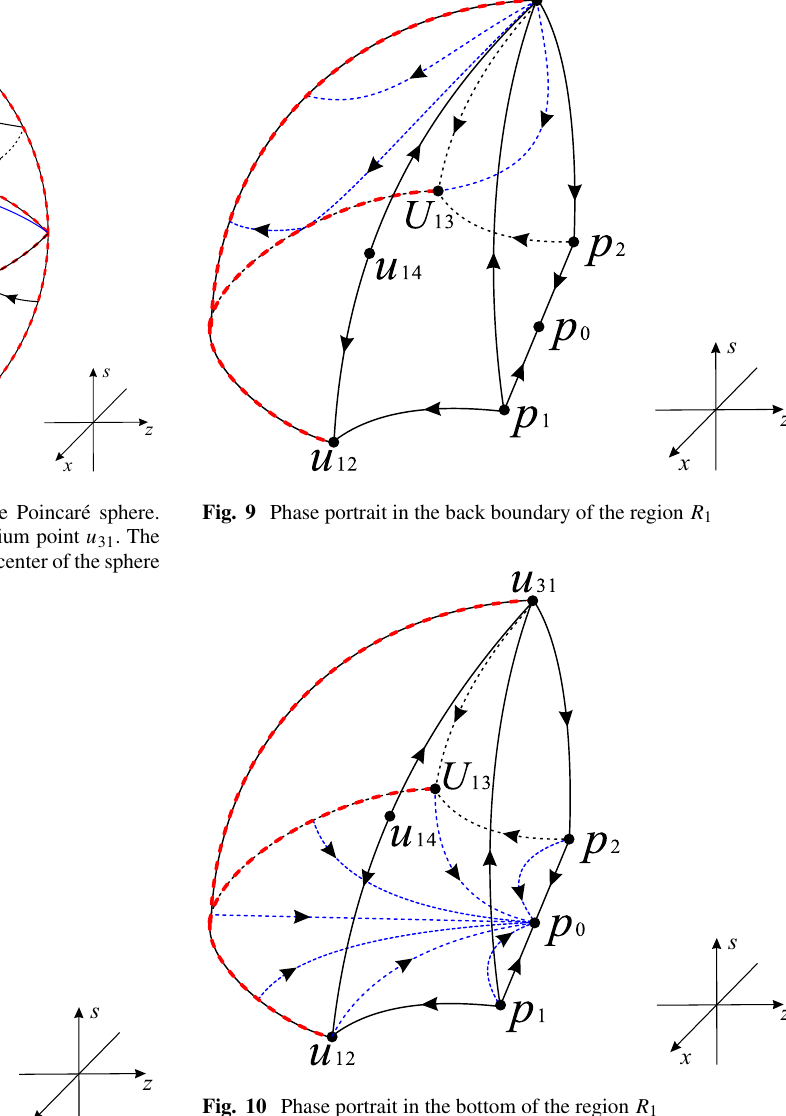
Fig. 10 Phase portrait in the bottom of the region R 1 parabolic sector segment of U 3 on the boundary F 3 , but it is unstable on the back boundary surfaces B 1 and B 2